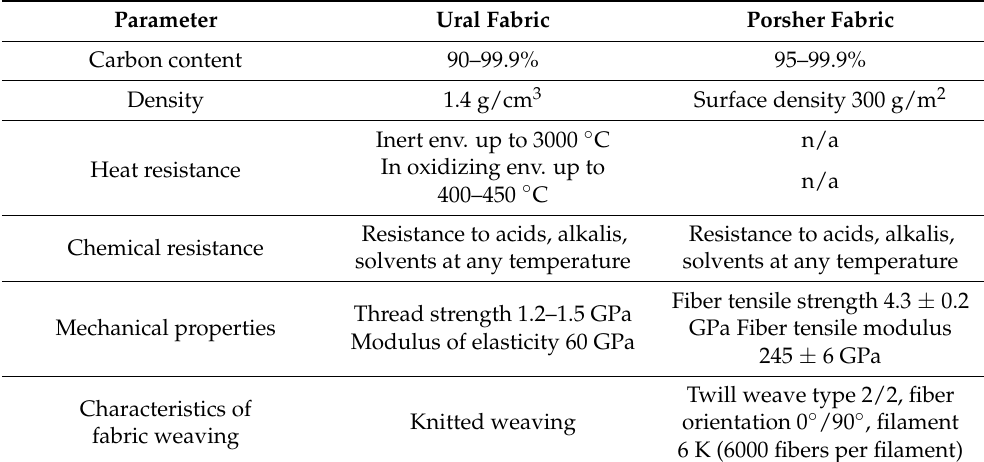
Table 1. The main technical characteristics of the carbon fabrics used.